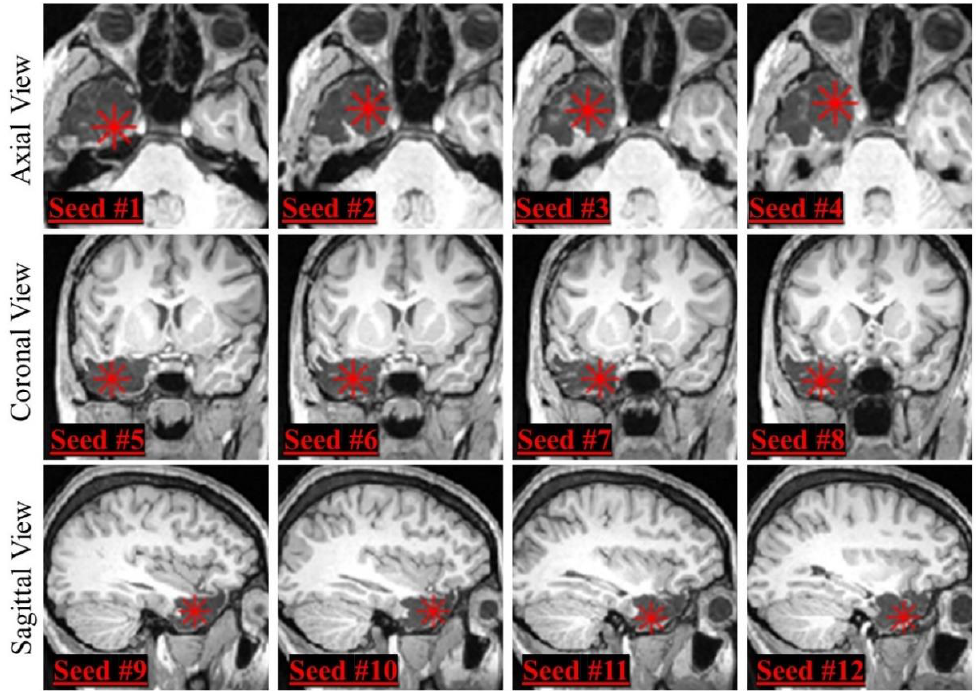
Figure 2. Seed positioning in different MRI views. We selected four seeds (indicated by red stars) from different slices from each MRI view (first row: axial view, second row: coronal view, third row: sagittal view), obtaining a total of 12 different seeds for each patient.